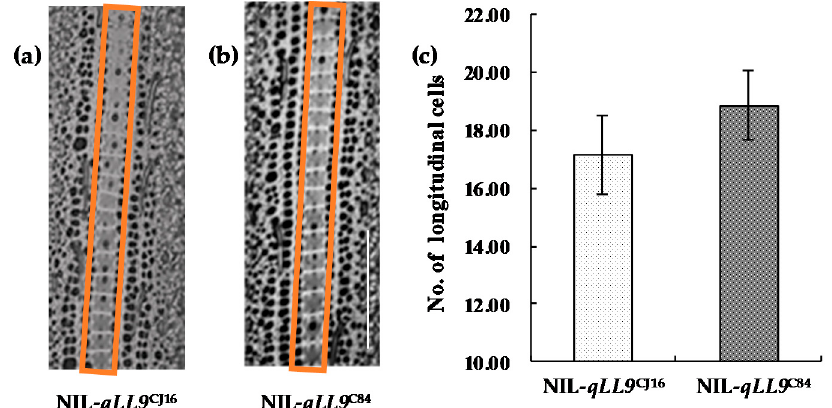
Figure 6. Histological cell morphology of NIL- qLL9 CJ16 and NIL- qLL9 C84 . ( a , b ) Comparison of cytological morphological characteristics in the orange boxes between the two genotypes of the NIL set; bar = 200 µ m. ( c ) Number of longitudinal cells in NIL- qLL9 CJ16 and NIL- qLL9 C84 . Data are mean ± SD ( n = 15) and no significant difference was found.